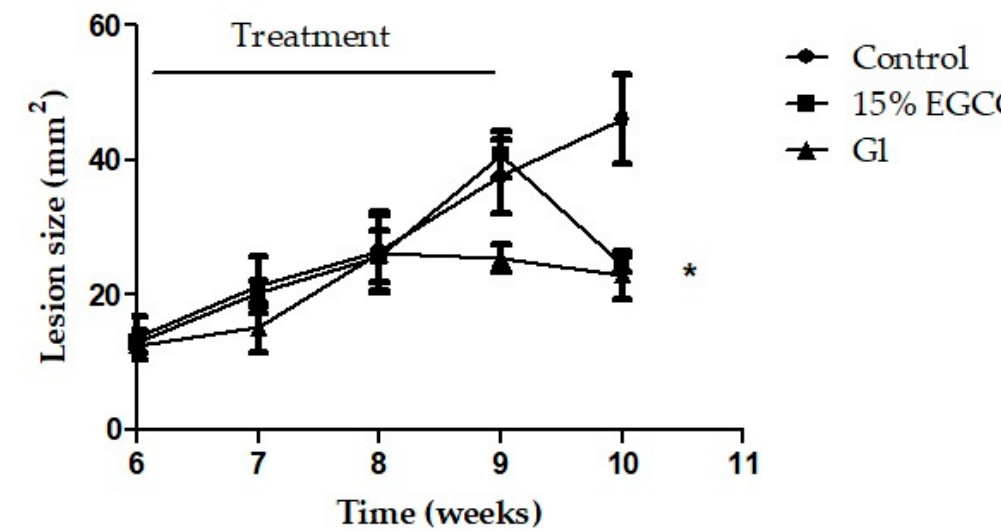
Figure 2. Evaluation of e ffi cacy of topical treatment with 15% EGCG in BALB / c mice infected with L. (L.) amazonensis . Animals were treated with 15% EGCG during 18 days, once a day, six times a week and Gl was administered by intraperitoneal route, once a day, six times a week (120 mg Sb v / kg / d). Lesions’ sizes of mice treated with topical 15% EGCG decreased significantly at week 10 compared to control group (untreated mice) ( p < 0.05). In addition, no di ff erence in lesion size was observed between mice treated with 15% EGCG and Gl, the first-line drug for the treatment of leishmaniasis. Lesions’ sizes in the control group increased as was expected.